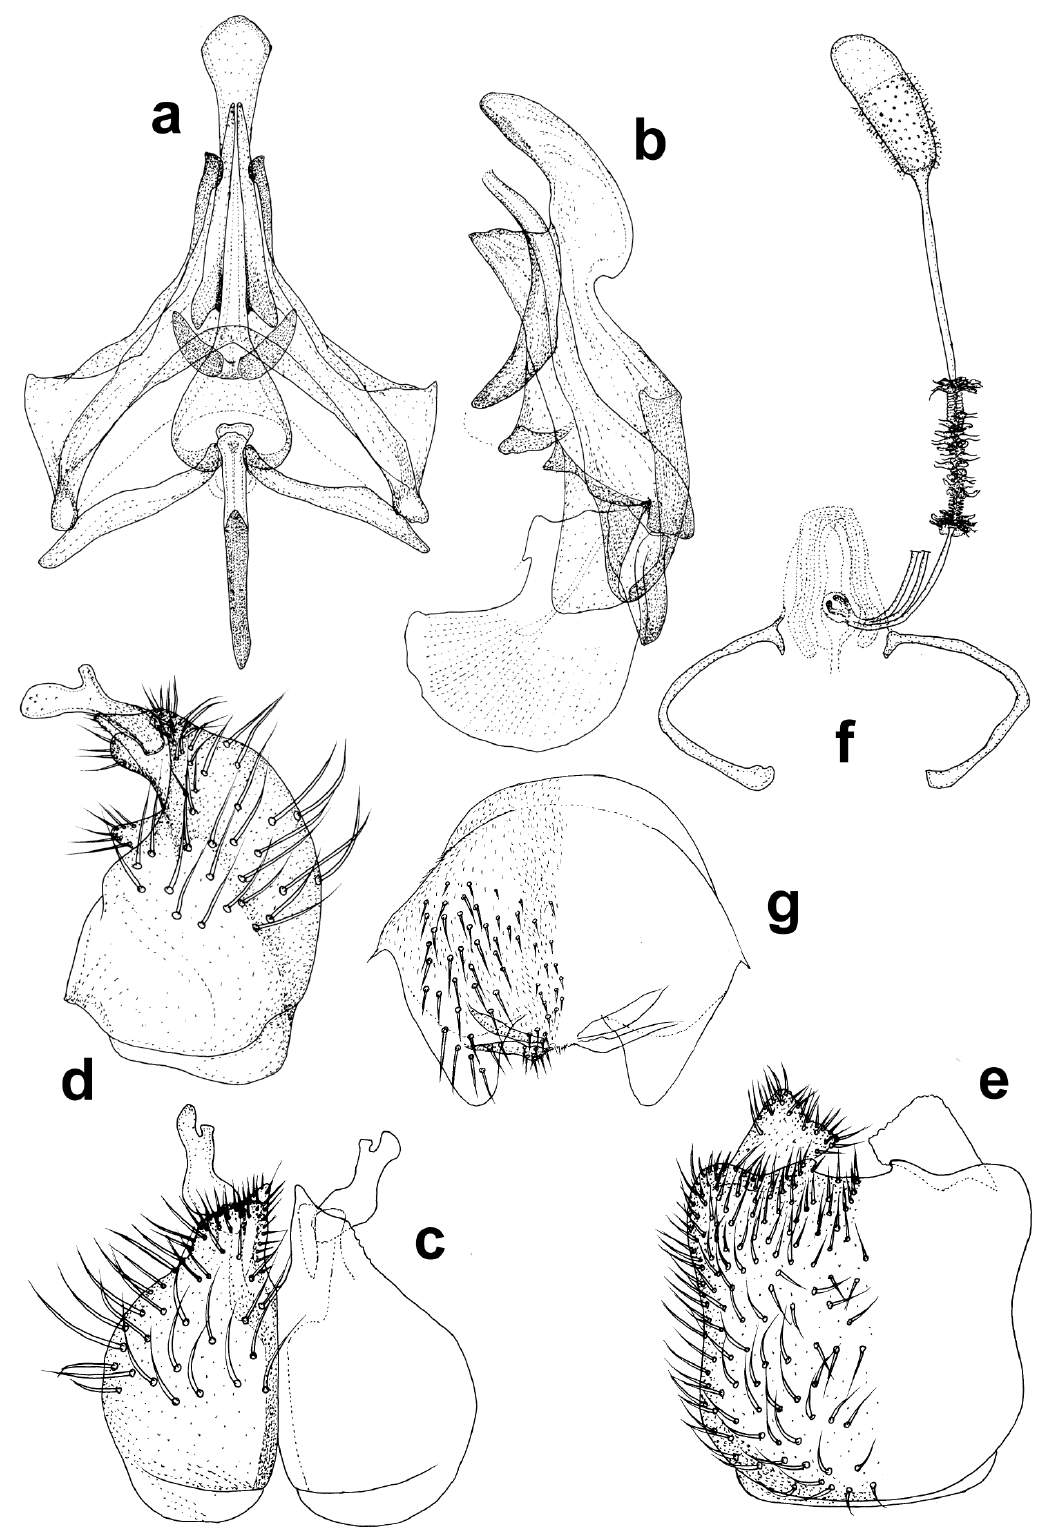
Fig. 34. Parageron erythraeus (Greathead, 1967). a . Epiphallic complex ventral, b . Epiphallic complex lateral, c . Gonocoxite ventral. d . Gonocoxite lateral. e . Epandrium dorsal. f . Female genitalia ventral. g . Female sternite 8